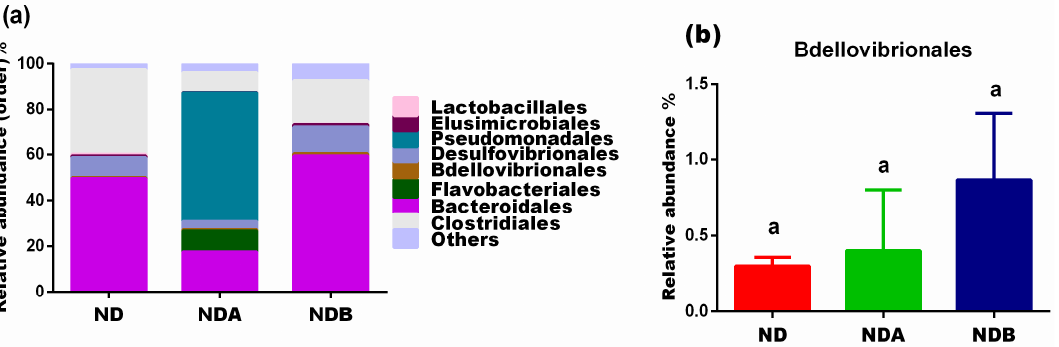
Figure 5. Effects of urolithins on gut microbial composition at the order level. Relative abundance at the order level ( a ), relative levels of the Bdellovibrionales ( b ). a Data are expressed as mean ± SE. Mean values bearing different letters are significantly different ( p < 0.05).